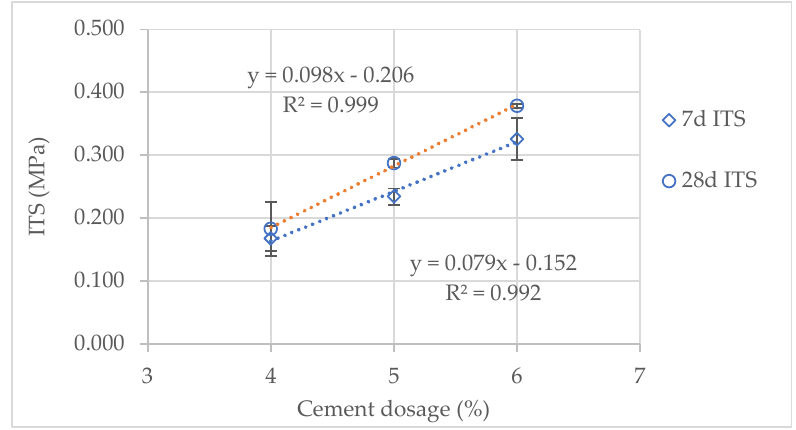
Figure 6. ITS of the red CTS after 7 and 28 days of curing.